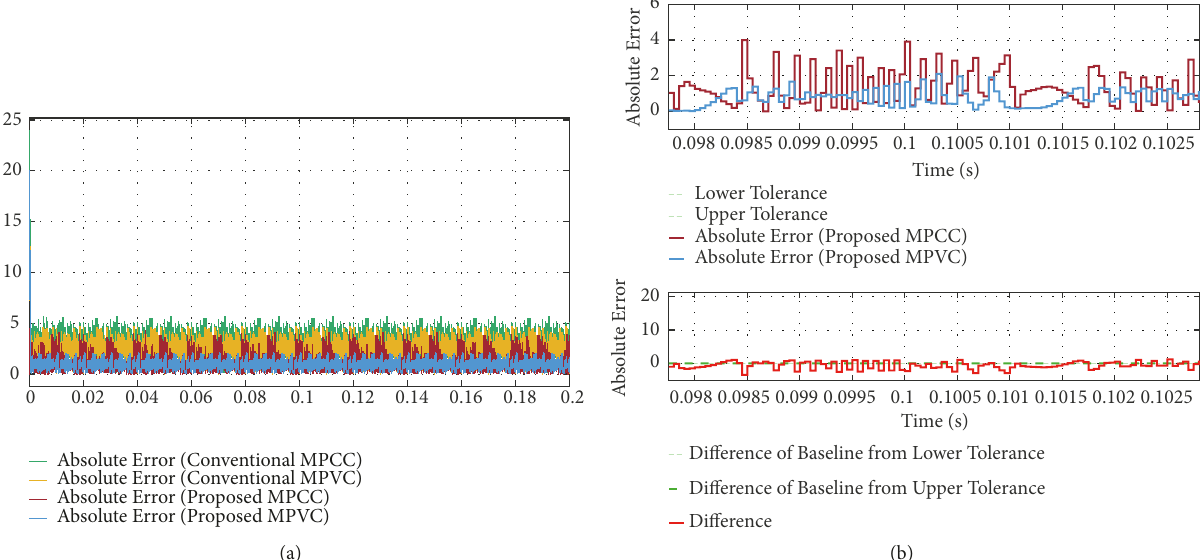
Figure 13: Absolute reference current tracking error. (a) Comparison of the conventional and proposed strategies. (b) Difference between proposed MPCC and